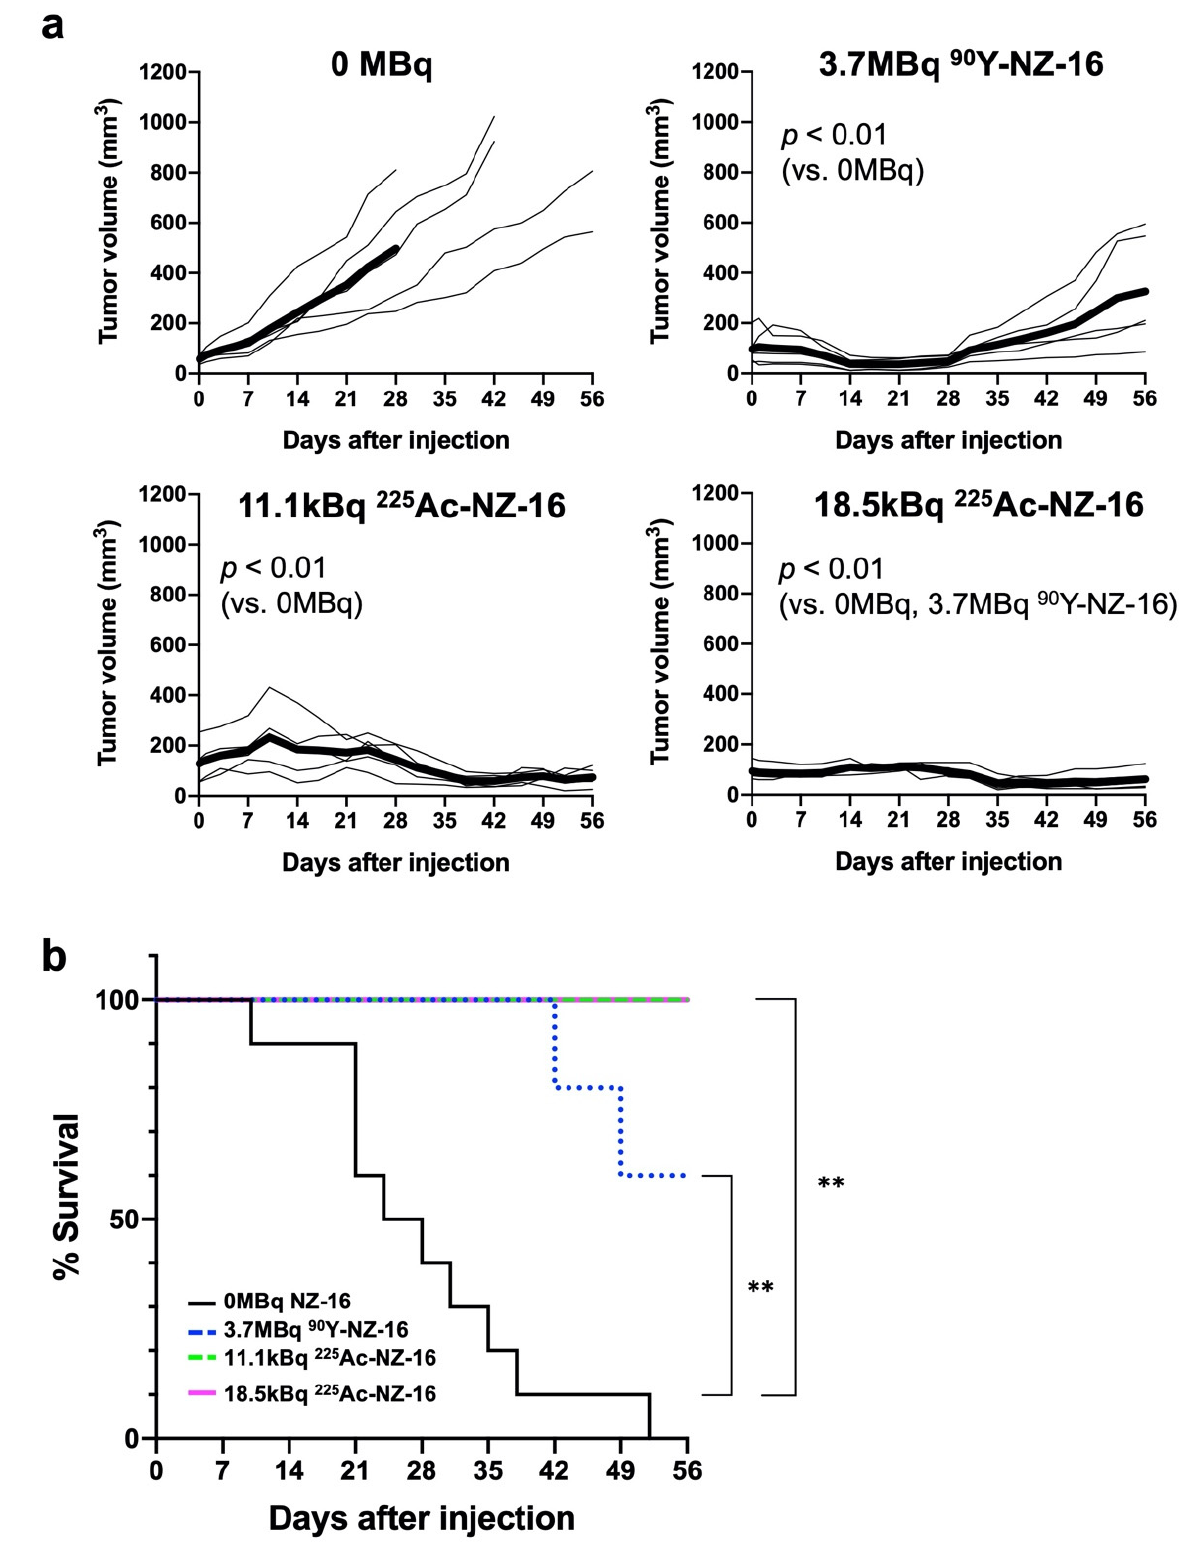
Figure 3. Therapeutic efficacy of 90 Y- and 225 Ac-labeled antibodies in H226 tumor-bearing mice (N = 5/treatment group). ( a ) Tumor growth curves of individual mice after injection with 90 Y- or 225 Ac-labeled NZ-16 (thin lines). Bold lines indicate the mean. ( b ) Kaplan–Meier survival curves based on a tumor volume endpoint of 300 mm 3 . ** p < 0.01, vs. 0 MBq NZ-16.